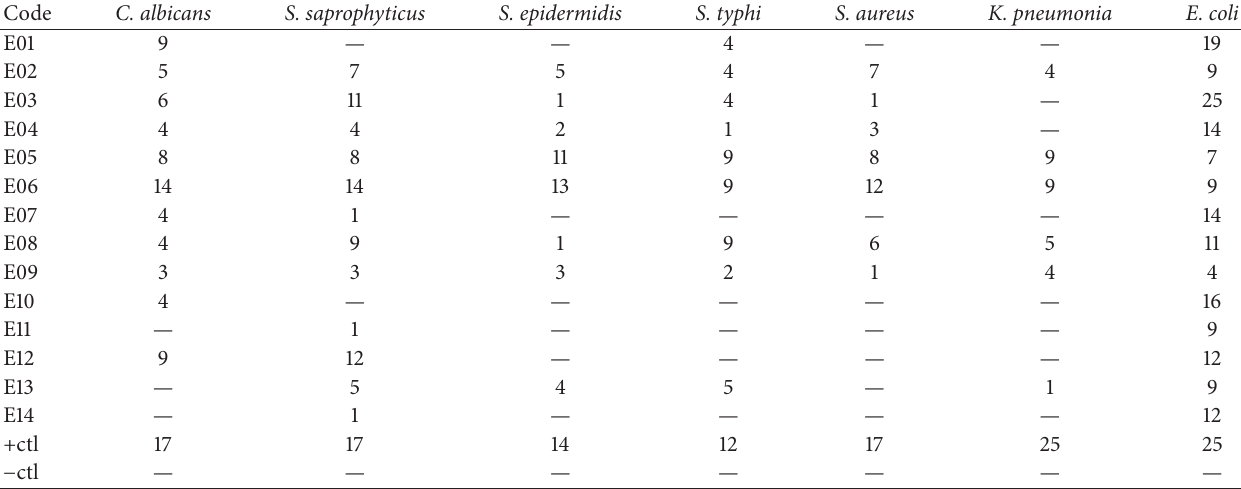
Table 3: Antimicrobial activity of extracts E01–E14: the hole-plate diffusion method was used to assess the antimicrobial susceptibility of crude extracts by measuring the diameter zones of inhibition in mm. The absolute values of the diameter of zones inhibition (DZI) varied from 0 to 25 mm.